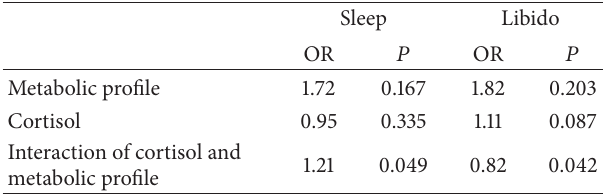
Table 7: Estimates of the logistic regression analysis on Zung